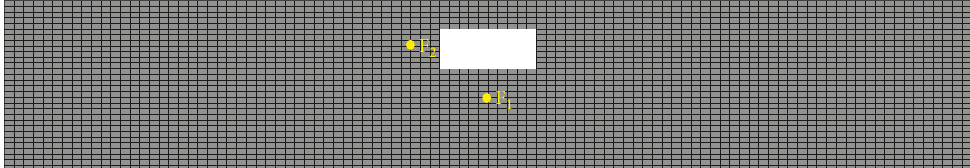
Figure 2: Finite element model of calculation.